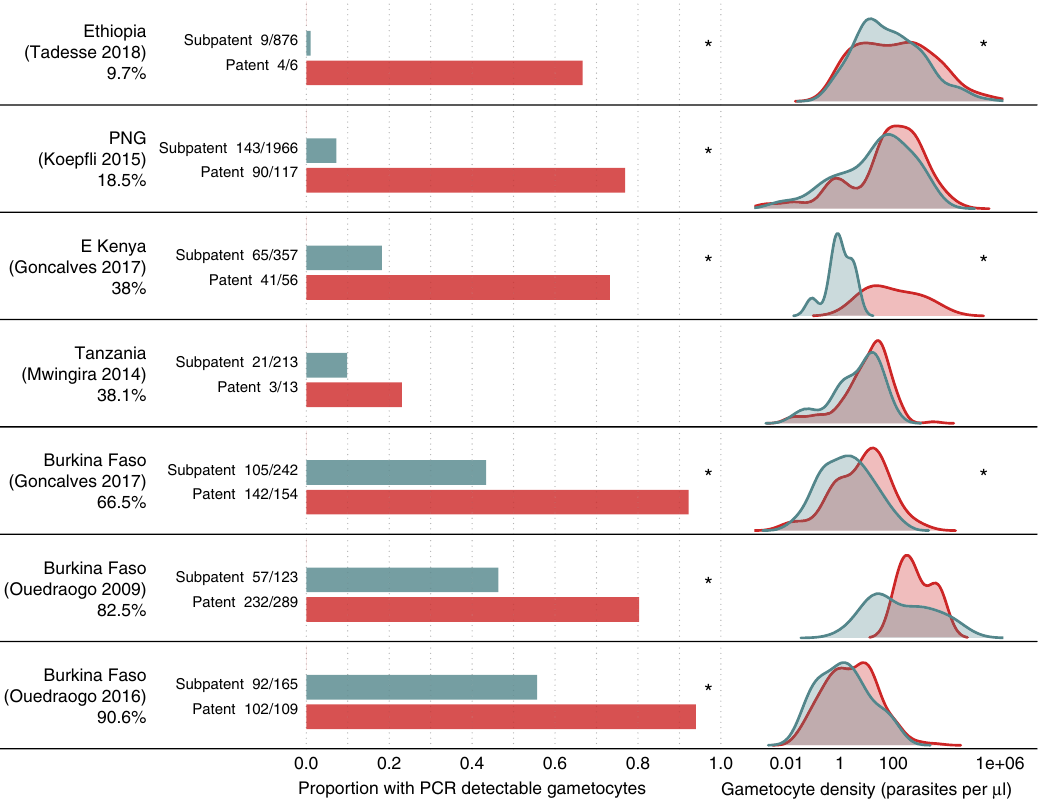
Fig. 6 Prevalence and density of gametocytes. Gametocyte prevalence and density of gametocytes in individuals with patent and subpatent asexual Plasmodium falciparum infections. The studies are ordered by community asexual prevalence (shown by the percentage under the study name), with the lowest at the top. The density plots show the gametocyte densities (by PCR) of individuals with patent asexual (red) and subpatent asexual (blue) infections. *Indicates statistical signi fi cance for the two tests described in the methods. There is poor comparability of gametocyte densities between different laboratories, therefore the plots in the right column should be used to compare between the patent and subpatent parasite density distributions in each study, rather than distributions between studies. Source data are provided as a Source Data fi